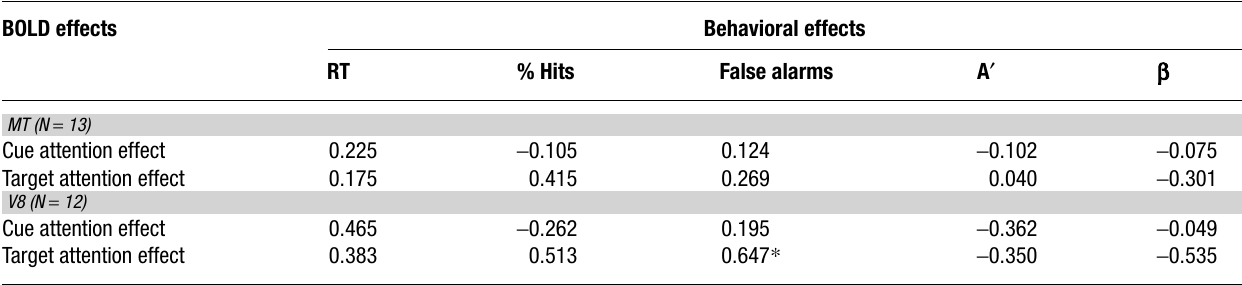
Table 4. Correlations between the effect of attentional cuing on hemodynamic (BOLD) responses and behavior on color trials. BOLD